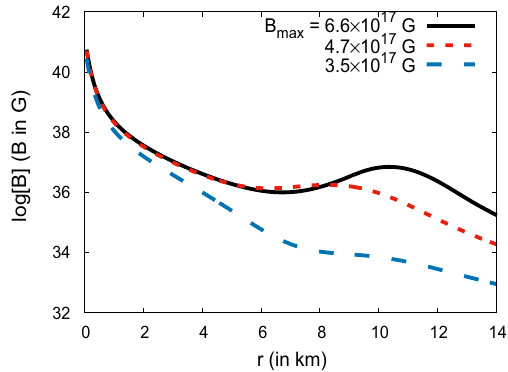
Fig. 4 Variation of the magnitude of the magnetic field with distance along the equatorial plane is shown for the TT magnetic field configu- ration. Nomenclature of the curve remains the same as Fig.